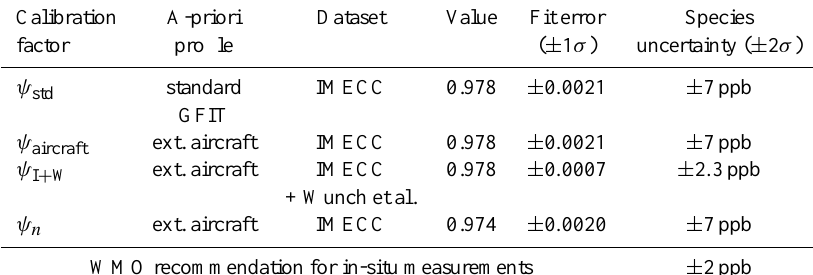
Table 3. Results of the IMECC campaign. Note: Wunch et al. (2010) derived a value of ψ = 0 . 978 ± 0 . 002.